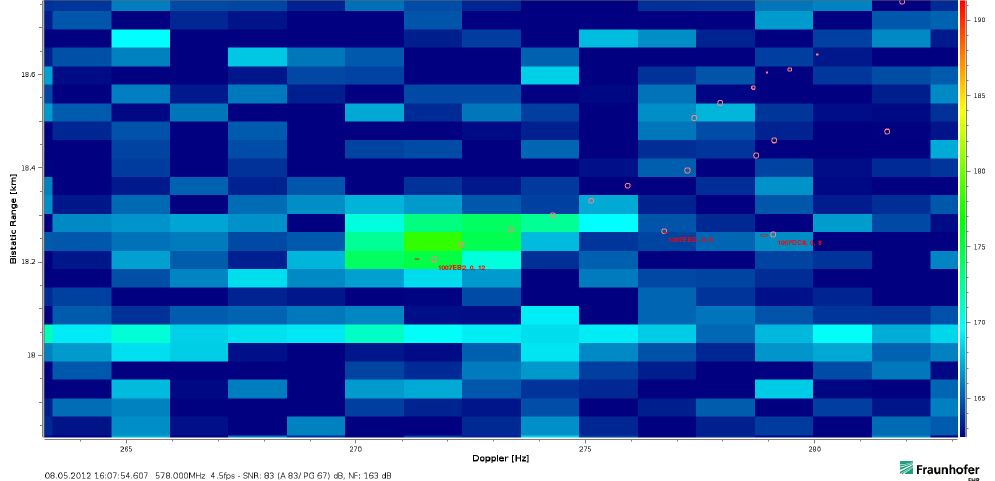
Figure 13. Moderate deceleration in addition to the Doppler frequency spread of a bistatic velocity of v eff ≈ 270km/h with track history indicating the change using T int = 717ms and T cov = 896ms.